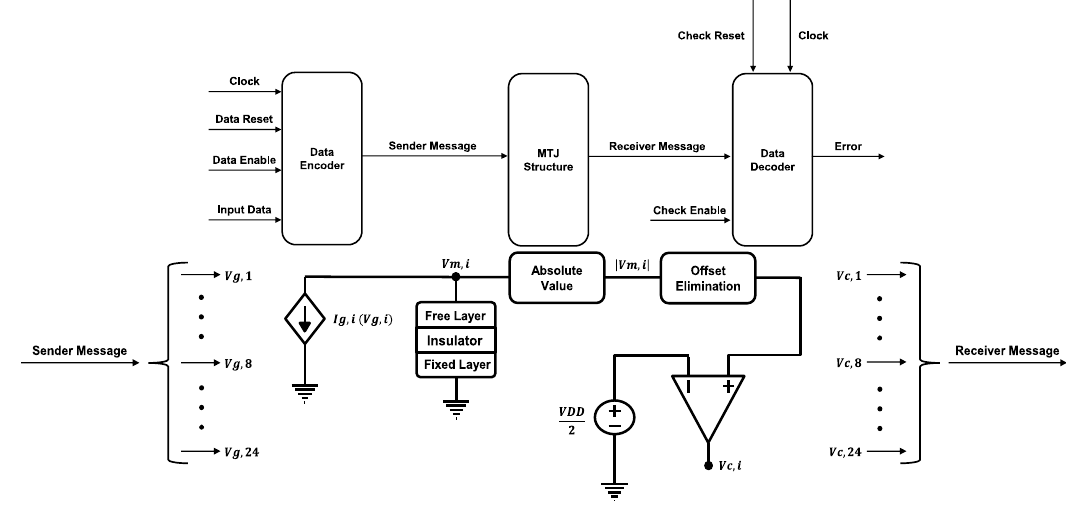
Figure 50. BISR ‐ RS architecture for the MTJs under attack. Figure 50. BISR-RS architecture for the MTJs under